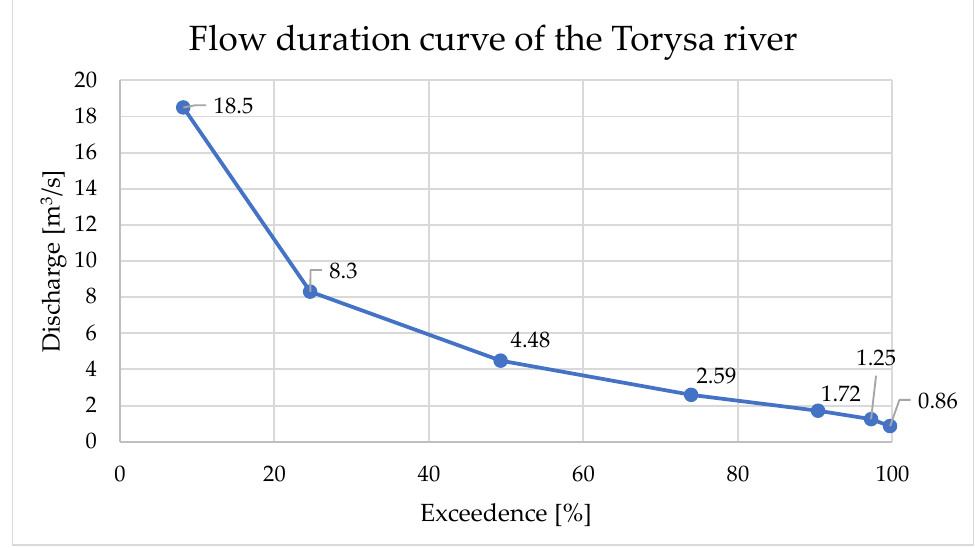
Energies 2022 , 15 , x FOR PEER REVIEW Figure 4. Flow duration curve of the Torysa river at hydrometric station Kosicke Olsany (8870). The altitudes at the individual points of the evaluated part of the Torysa river were obtained using a DEM model, the defined points forming the basis for determining the head of the individual elementary sections. The assessed part of the Torysa river is bounded by the altitude h 1 = 316.4 m at the location of the river kilometre 79.6 km and the height h 3 = 179.6 m at the location of the river kilometre 13.0 km, which also correspond to the border hydrological stations. The hydrological station located in the middle section on the 58.3 river kilometre is located at an altitude of h 2 = 235.0 m.